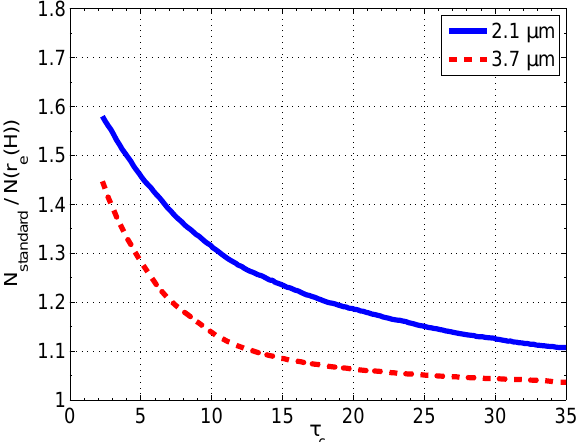
Figure 4. The ratios of N d values from the standard MODIS calcu- lation (using the retrieved r e for r ∗ e in Eq. 10) to those from the cor- rected calculation (using the corrected r e for r ∗ e as calculated from the retrieved value and g re ; the g re values used are those shown by the black line in Fig. 1) vs. retrieved τ